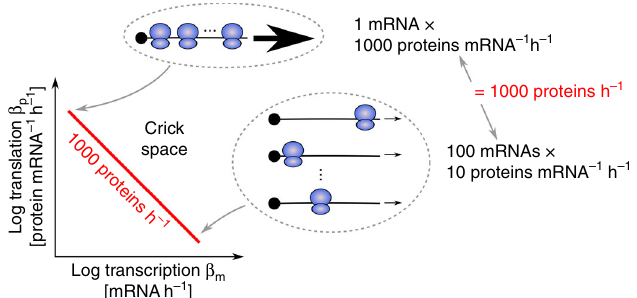
Fig. 1 For each gene, an in fi nite number of combinations of transcription and translation rates can achieve a given protein abundance. For example, to obtain 1000 proteins per hour, one possibility is to translate 1000 proteins per hour from a single mRNA. Another option is to translate 10 proteins per hour from 100 mRNAs. We assumed fi xed mRNA and protein decay to simplify the visualization. See also Supplementary Fig.